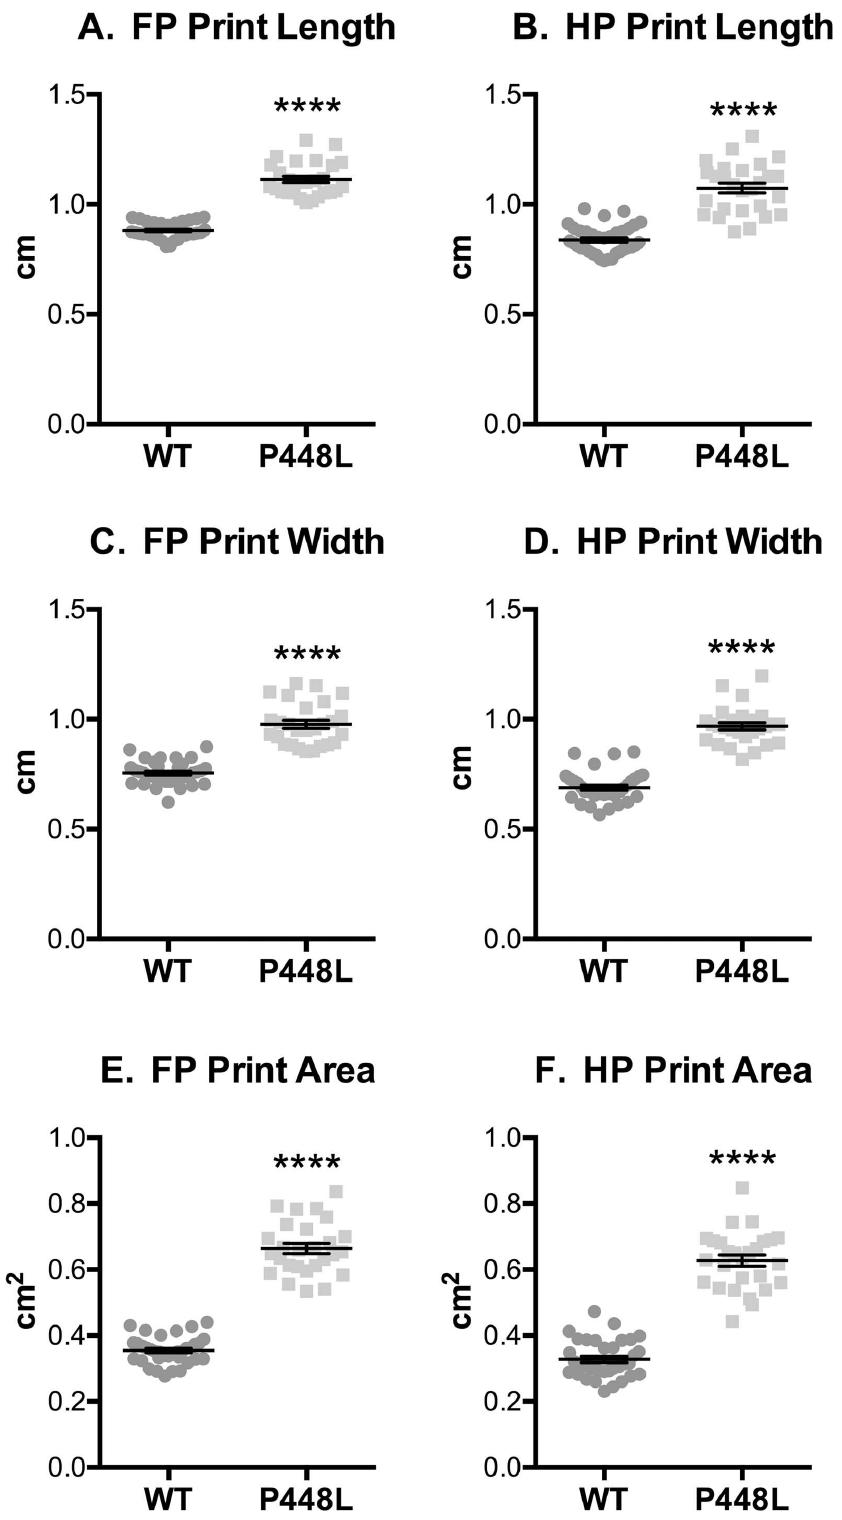
Fig 4. Paw Contact/Print Area. Fore paw and hindpaw measurements of printlength(A,B),width (C,D) and area (E,F)recordedfromthe entirestance phase. (FP = fore paw, HP = hindpaw, n = 12; **** p (cid:20) 0.0001).